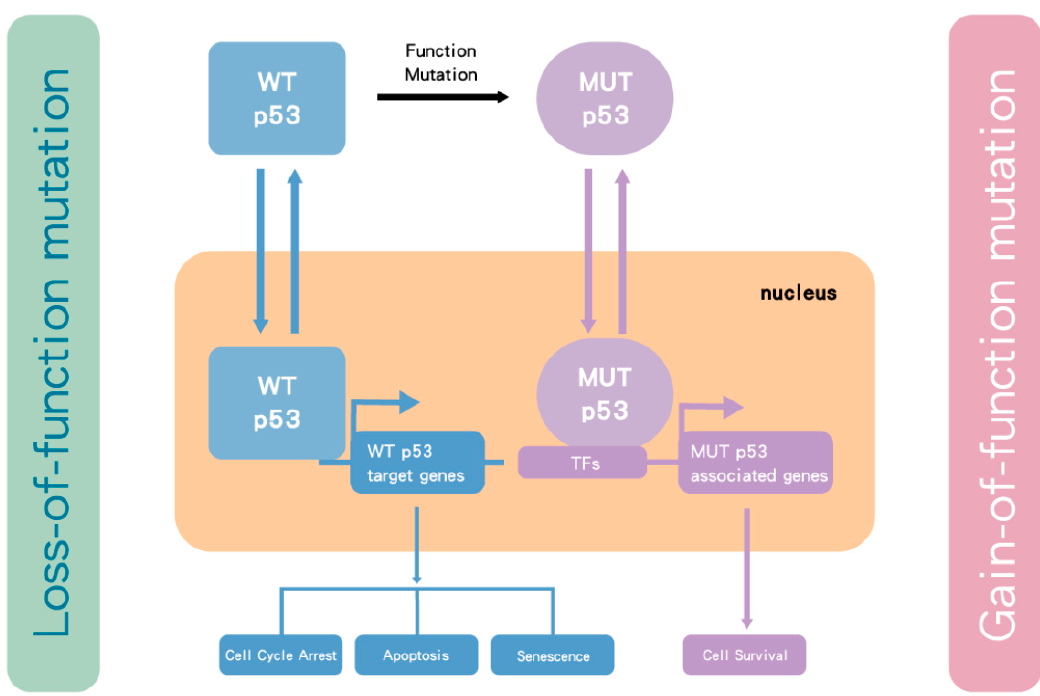
Figure 1. The influence of TP53 mutation in cancer cells. p53 is a transcription factor that transactivates downstream genes responsible for cell cycle arrest, apoptosis and cell senescence. Once p53 becomes mutated (MUT), it loses wild-type (WT) p53 function. In some cases, the mutant form selectively accumulates due to loss of binding to MDM2. As p53 functions as a tetramer, the mutant and functionally defective form then dominates over the lower number of wild-type p53 protein molecules from the remaining normal allele. However, for the most part, TP53 behaves as a classical tumor suppressor gene and both alleles need to be inactivated by a combination of mutation and/or deletion. Nevertheless, some mutant forms of p53 bind to transcription factors (TFs), which transactivate genes responsible for tumor survival and drug resistance. Taken together, MUT p53 enhances tumor growth.